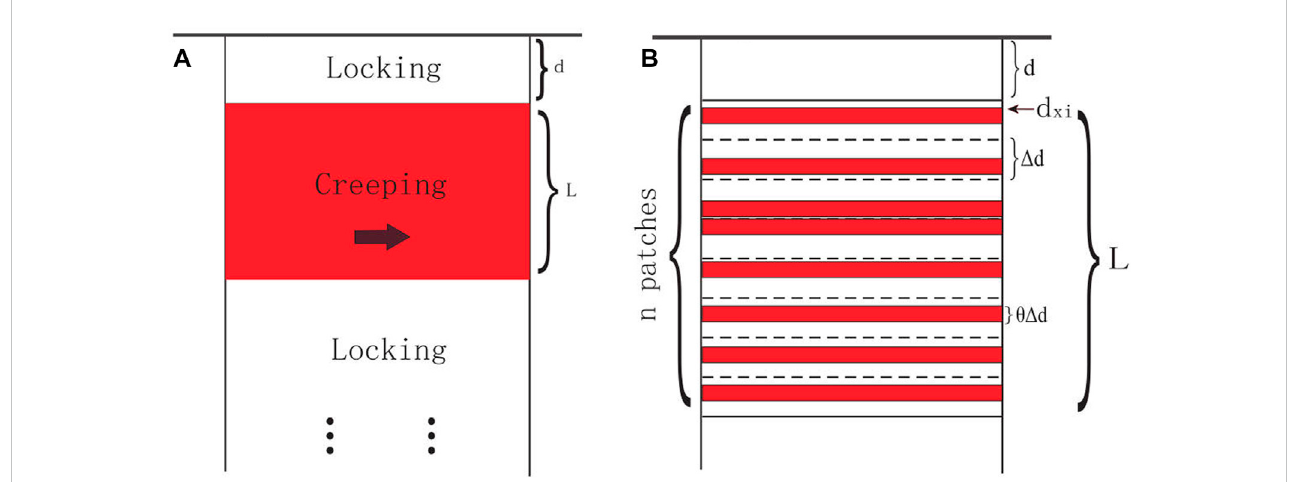
FIGURE 2 Red and white patches represent creeping and locking segments, respectively. (A) Model of the strike-slip fault with a fi nite locking segment length. Surface deformation is s